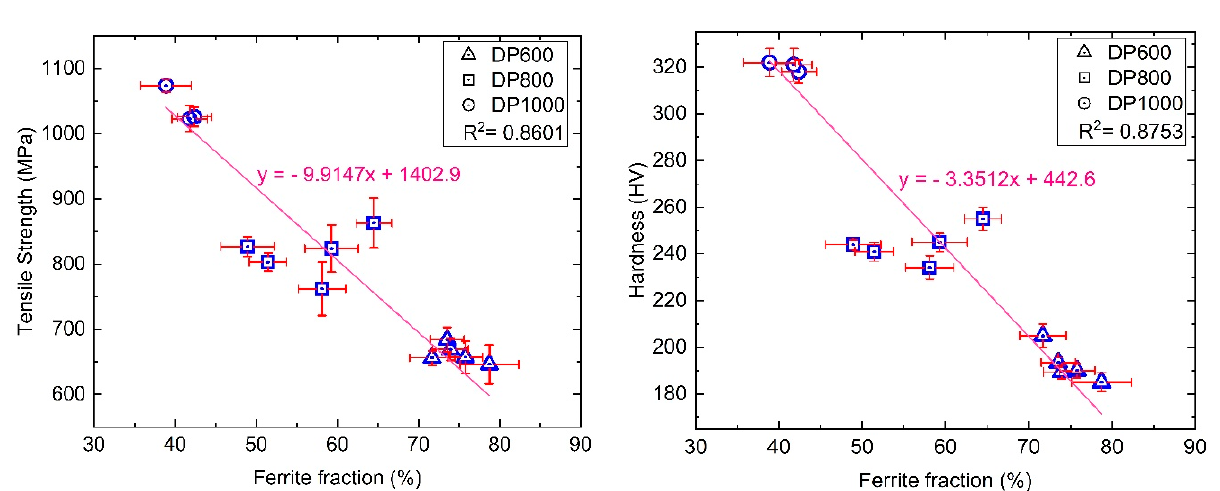
Figure 2. Tensile strength ( left ) and hardness measurement ( right ) versus ferrite fraction for the commercial DP600, DP800 and DP1000 steel samples.